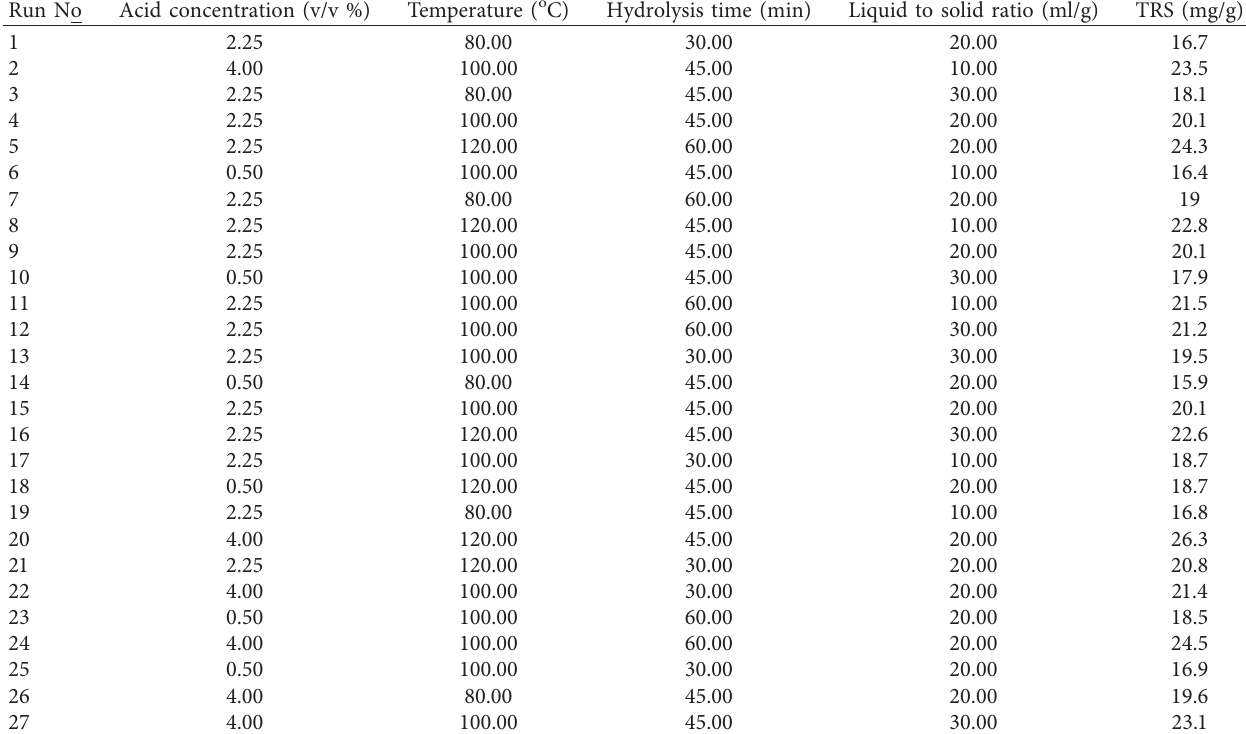
Table 2: Experimental results for the dilute acid hydrolysis of Teff straw for total reducing sugar (TRS) yield. Run